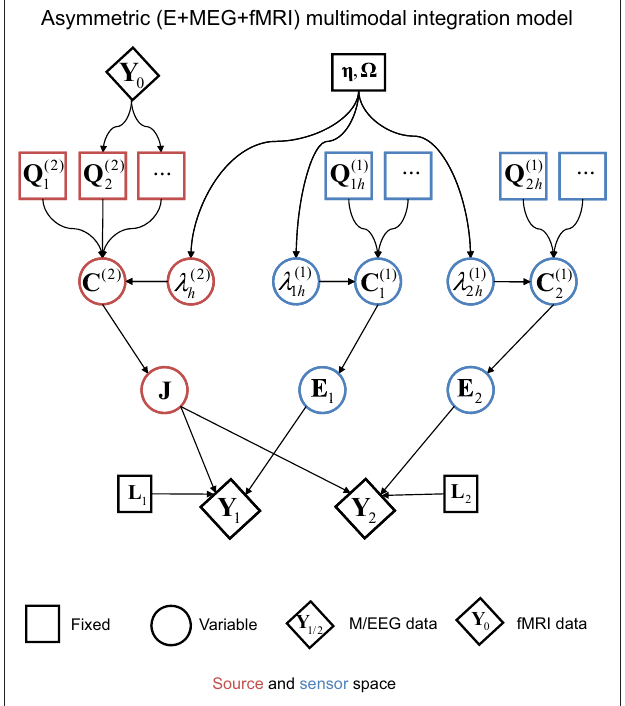
Figure 9 | A possible symmetric model for fusion of eeg/Meg data and fMri data (cf. Figure 7).